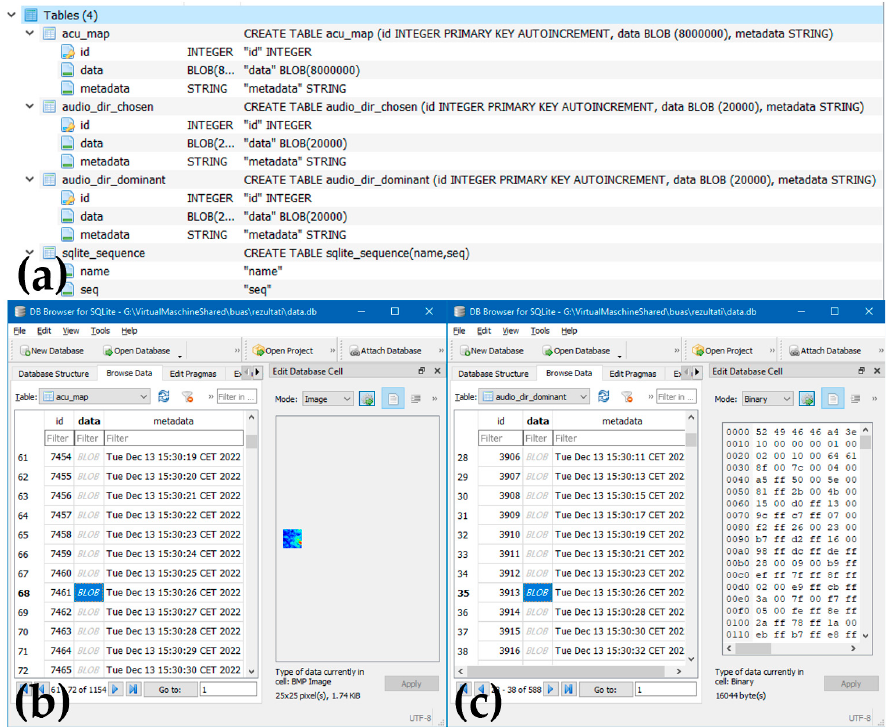
Figure 12. The AC SQLite database storing data during operation, shown with DB Browser for SQLite: ( a ) list of tables; ( b ) acoustic map table (bmp data in the BLOB field); ( c ) dominant direction table (wav data in the BLOB